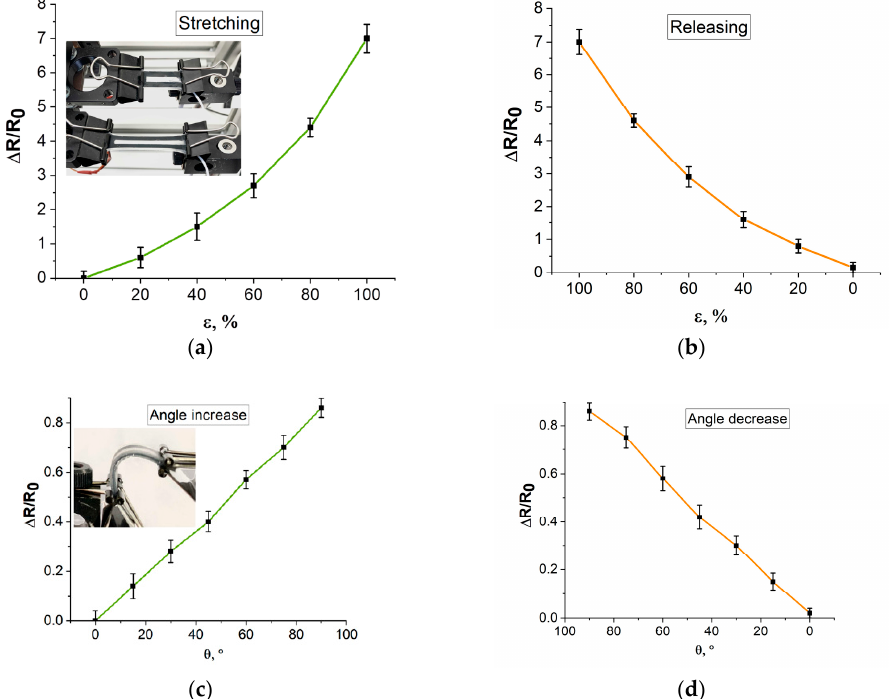
Figure 7. Resistance dependence of elongation while: ( a ) stretching (insert—the process of stretching the sensor), ( b ) releasing, resistance dependence of angle while; ( c ) increasing the angle (insert—the process of bending the sensor); ( d ) decreasing the angle.